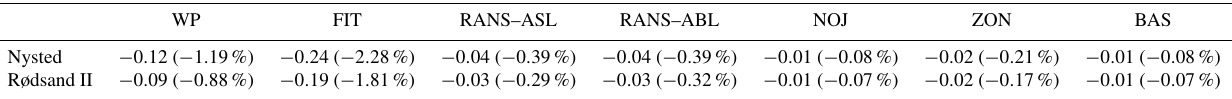
Table 9. Wind speed deficit 5 rotor diameter ahead of Nysted (for NYRØ) and 5 rotor diameter ahead of Rødsand II (for RØ) for the different wake models. Results are taken from the closed grid points for PyWake and PyWakeEllipSys and are interpolated to 5 rotor diameter for WRF. All results are averaged in the north–south direction over the dashed pink area A2 in Fig. 2. WP FIT RANS–ASL RANS–ABL NOJ ZON BAS